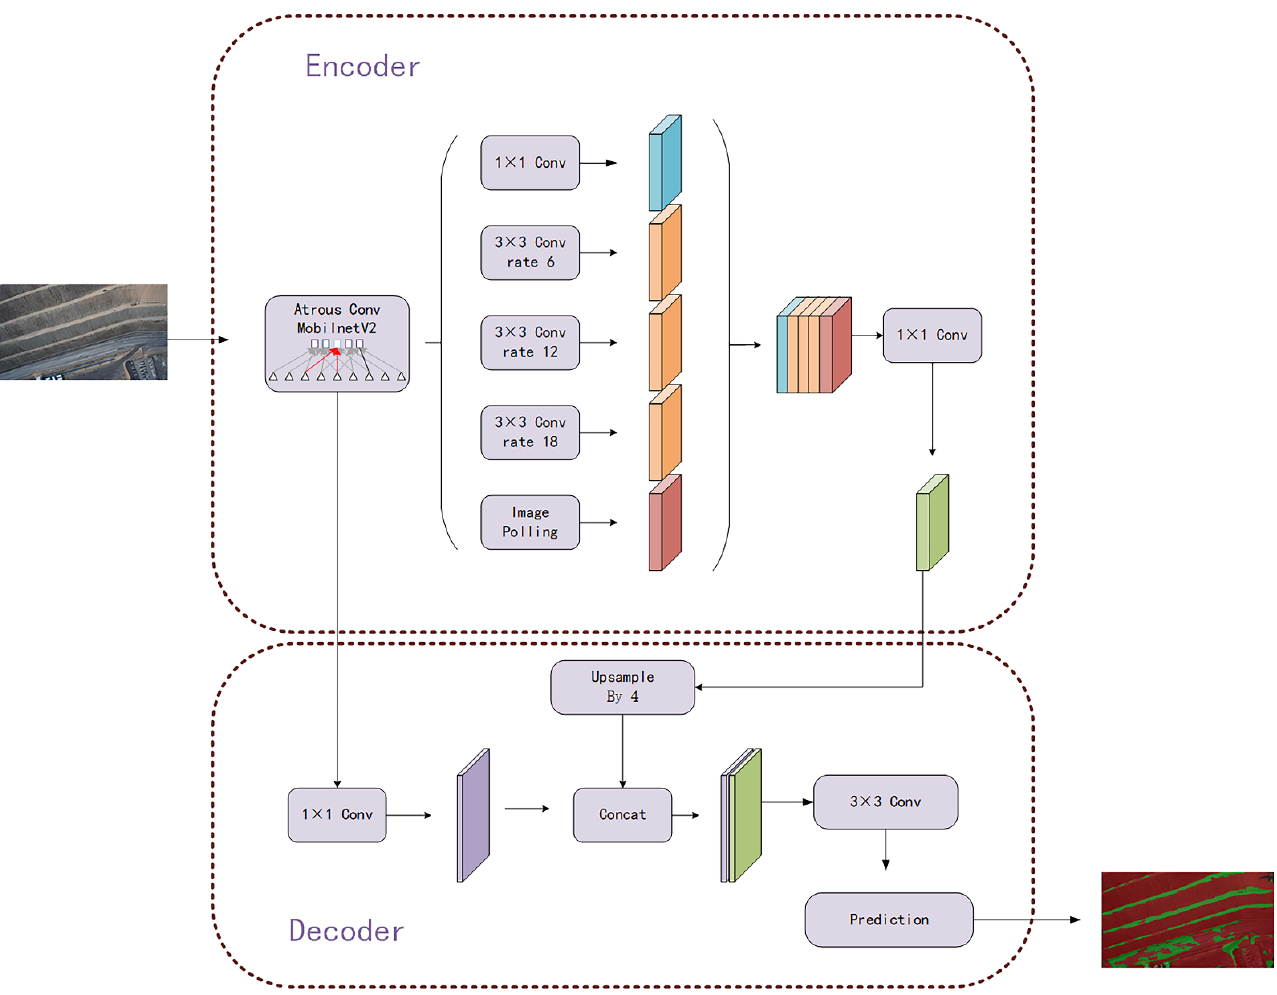
Figure 7. Grassland division model.